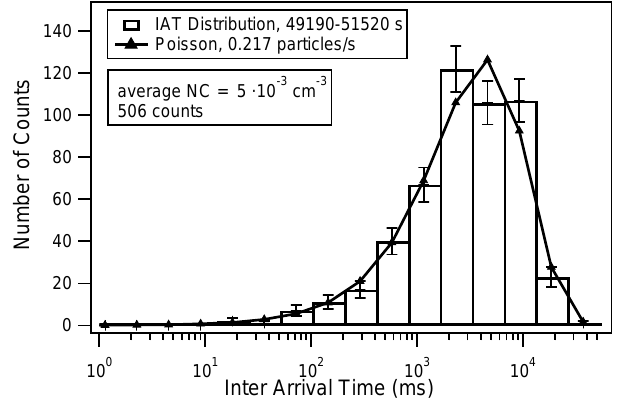
Figure 4. The distribution of the inter-arrival times (IATs) based on the CDP’s particle-by-particle data is used to check the quality of the PSC measurement (11 December 2011). The distribution shows IATs of PSC particles detected in about 40min of flight time (i.e., 400km), which is in good agreement with the Poisson statistics (tri- angle marks). This implies that the detected particles were randomly distributed in a homogeneous cloud field. The CDP’s (or FSSP’s) counting statistics are not sufficient to resolve small spatial varia- tions in the number density on a scale below about 200–400km. The distribution consists of 506 particle counts with an average number concentration (NC) of 5 × 10 − 3 cm − 3 , which corresponds to a count rate (i.e., probability) of 0.217 particles per second. This rate and the total number of counts are the parameters of the Poisson probability